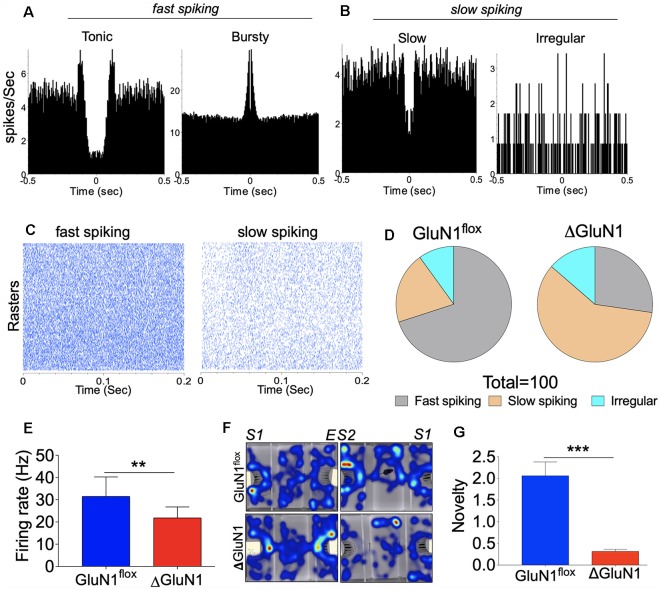
Firing rate (spikes/sec) characterization of the CA1 spike train. (A,B) Representative autocorrelogram for typical fast and slow spiking CA1 neuron units. (C) Perievent raster representation of fast and slow spiking CA1 units. (D) Pie chart depicting the percentage of fast, slow and irregularly firing CA1 neuron units. (E) Bar graph showing statistical comparison of mean firing rates (Hz). (F) Heat map demonstrating sociability and social novelty exploration pattern. (G) Bar graph illustrating social novelty memory index (E,G; **p < 0.01, ***p < 0.001).